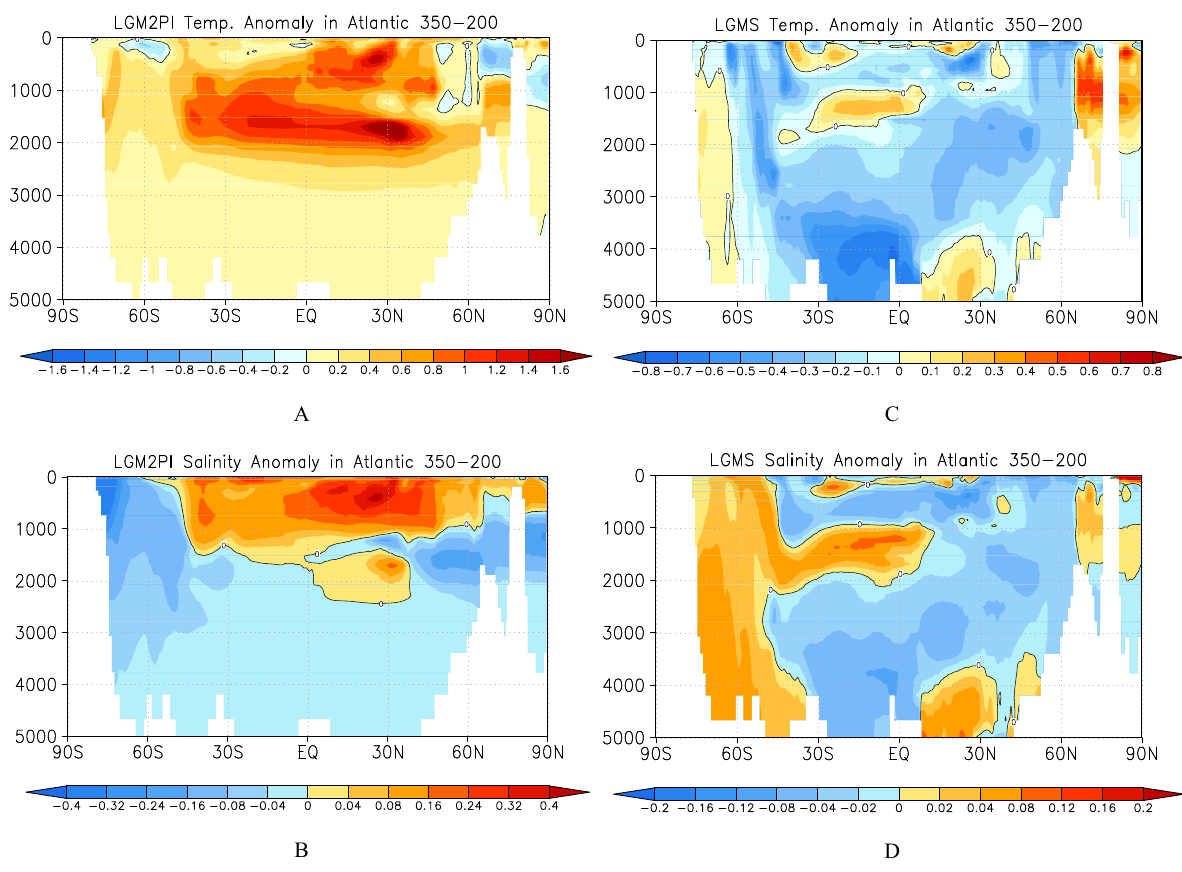
Fig. 13. Zonal mean temperature (A, C) and salinity (B, D) anomalies between the 350th and 200th model year in LGM2PI (A, B) and Figure 13 Zonal mean temperature (A, C) and salinity (B, D) anomalies LGMS (C, D) . Note that the range of color bar in LGM2PI is twice as large as in between the 350 th and 200 th model year in LGM2PI (A, B) and LGMS (C, D). Note that the range of color bar in LGM2PI is twice as large as in LGMS.